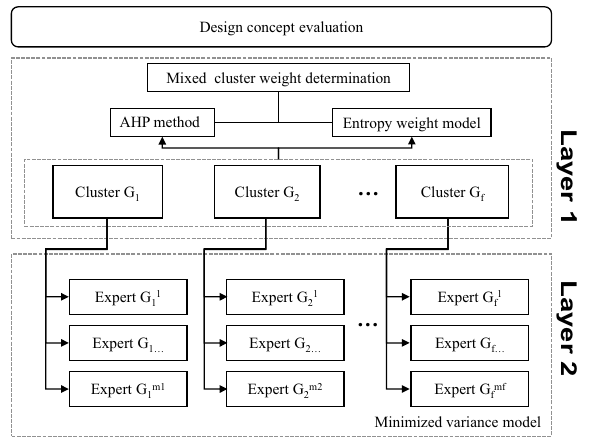
Figure 7. The framework of the proposed